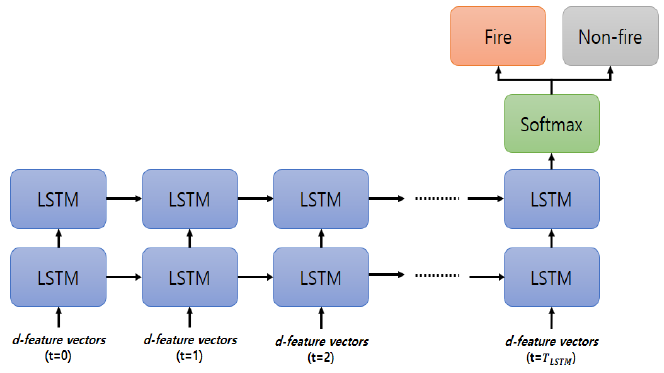
Figure 7. The long short-term memory (LSTM) network for fire detection.